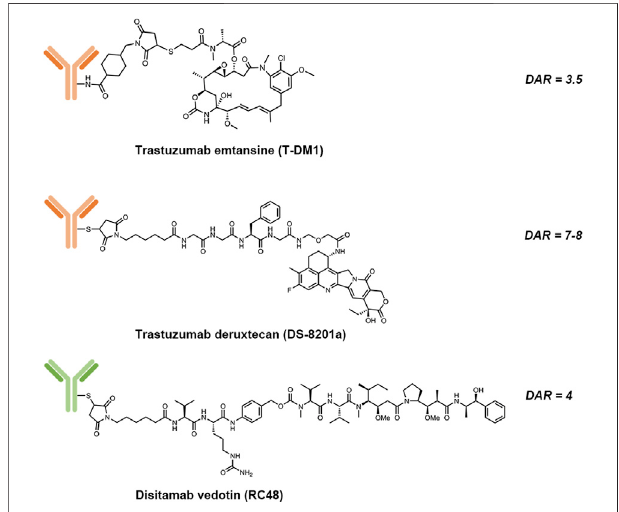
FIGURE2| Structures oftrastuzumab emtansine (T-DM1),trastuzumab deruxtecan (DS-8201a) and disitamab vedotin